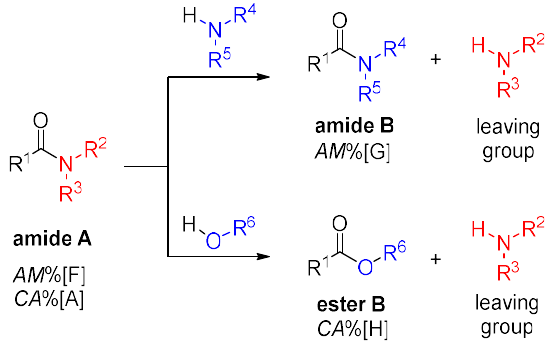
Figure 4. General transamidation reaction and the amidicity (AM%) and carbonylicity (CA%) percentages of the amides examined.